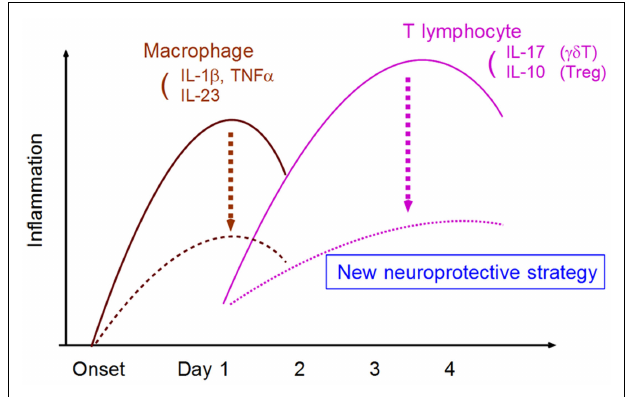
FIGURE 5 | Strategy for developing neuroprotective therapy by suppressing neurotoxic inflammatory response. The targeting of specific inflammatory mediators from macrophages andT lymphocytes can attenuate neurotoxic inflammatory